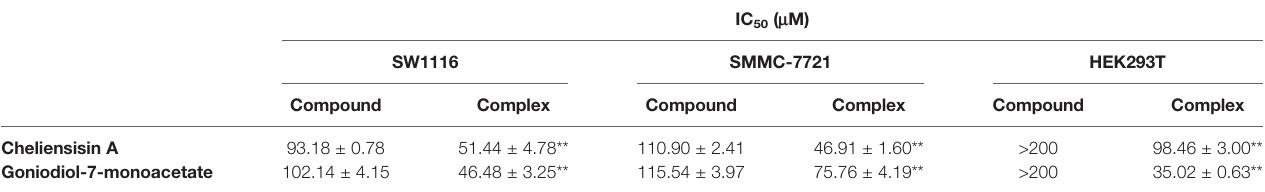
TABLE 2 | Cytotoxic activity of styryllactones increased after complexation with Hydroxypopyl- b -cyclodextrin (HP- b